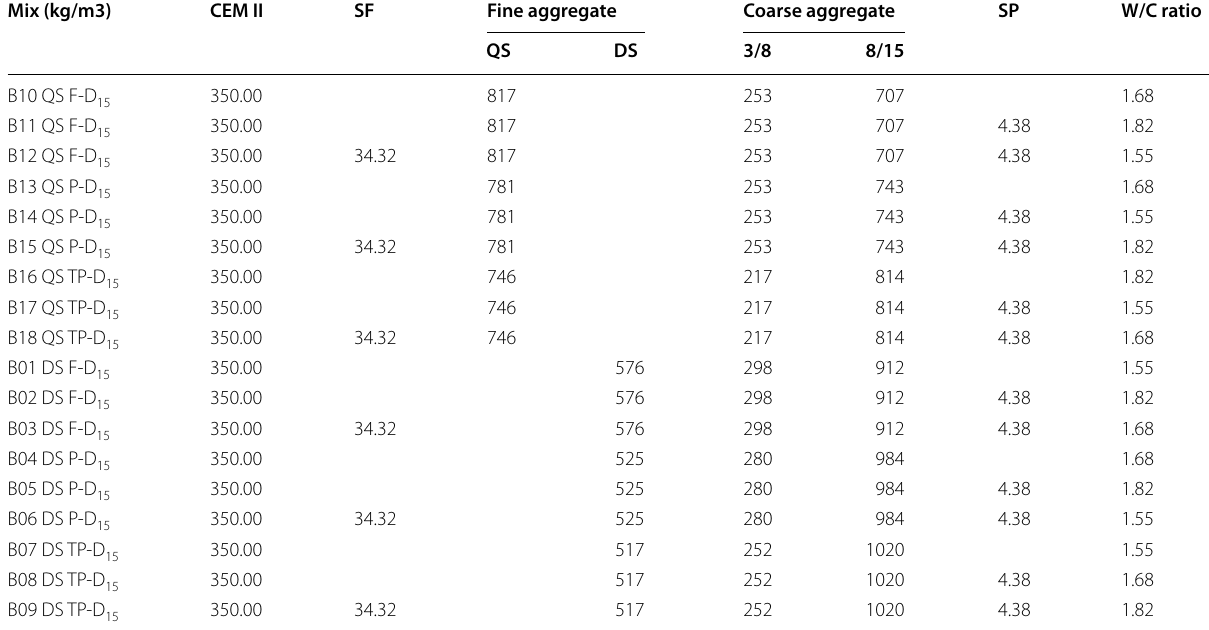
Table 3 Mixture proportions of concrete D 15 .